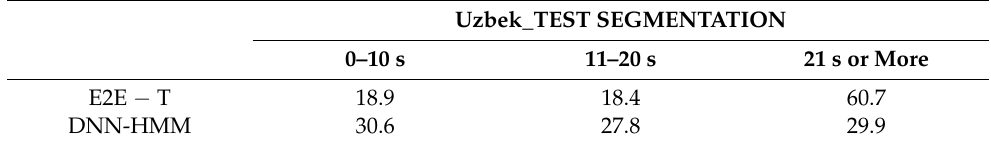
Table 10. E2E − T transformer and DNN-HMM WER (%) outcomes with segmentation ranges of 0–10 s, 11–20 s, and 21 s or more on the Uzbek_Test